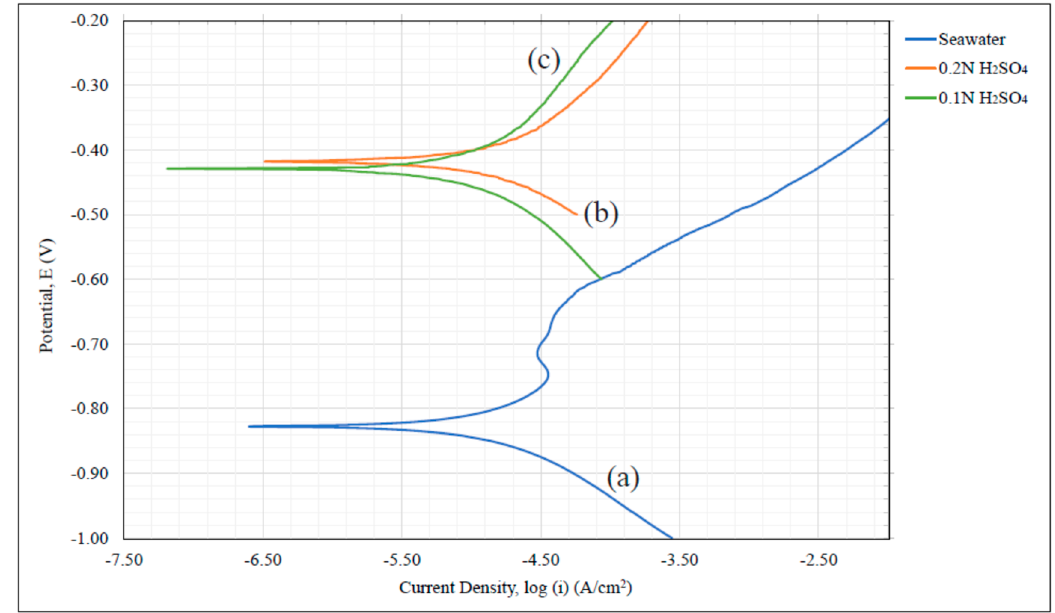
Figure 3. Polarization curves for Al 1235 in seawater from [ − 0.78, − 0.64] V as curve ( a ), 0.2 N H 2 SO 4 from [ − 0.54, − 0.40] V as shown by curve ( b ), and 0.1 N H 2 SO 4 from [ − 0.58, − 0.44] V as curve ( c ). For each curve, a horizontal line may be drawn, which denotes to the location of pseudo E corr . In addition, positive and negative sloped lines can also be constructed to determine β a and β c rates respectively. Finally, a vertical line can be drawn, which provides the pseudo i corr . Refer to Table 1 for data reduction.